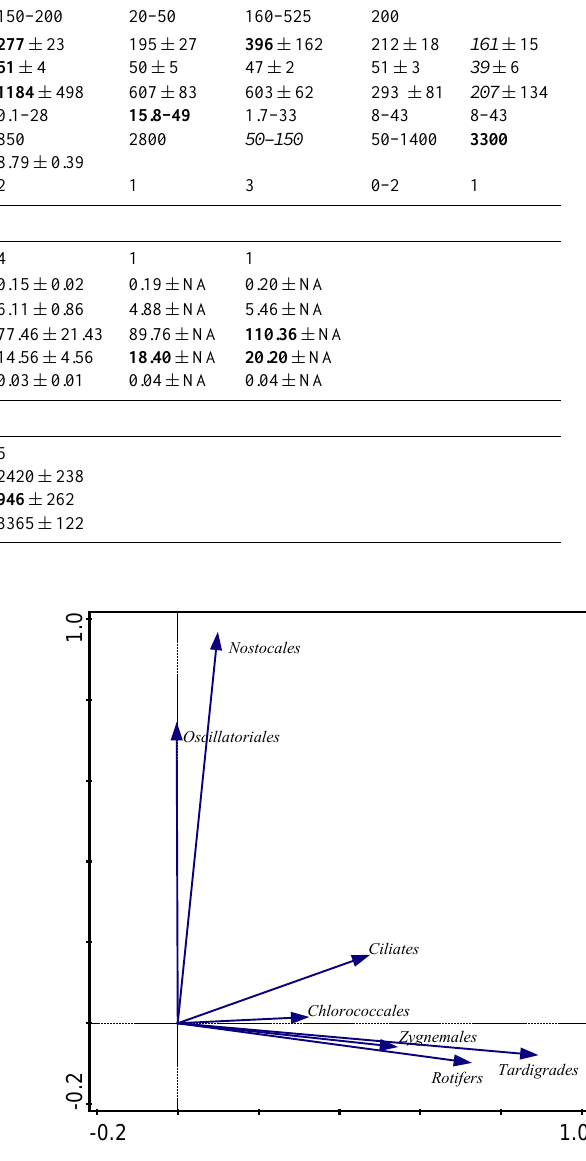
Figure 3. PCA biplot of all organisms collected in this study. Euclidean dissimilarities were used. The data are log-transformed and microalgal biovolumes were standardized by multiplication by 10 − 6